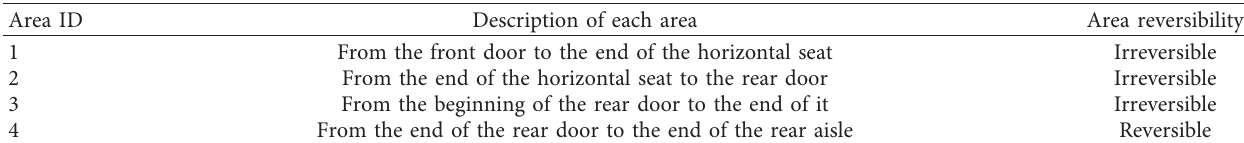
Table 2: Description of each standing area.